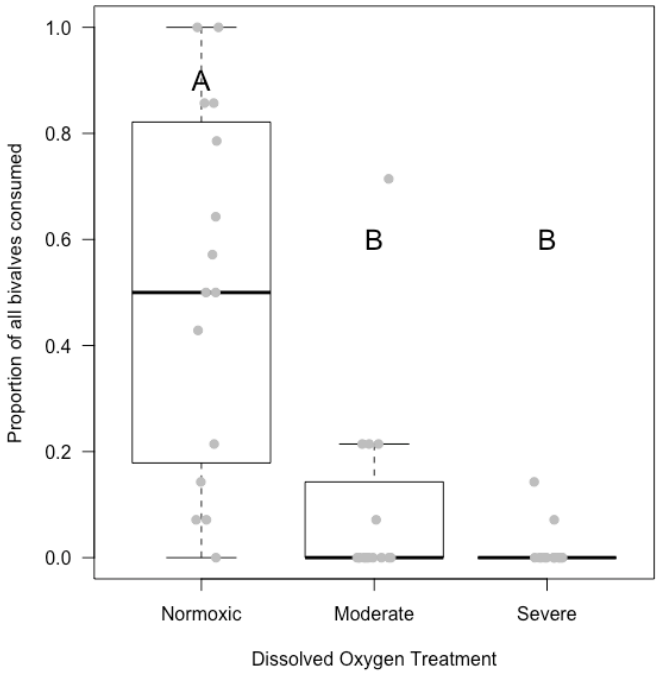
Figure 4. ( a ) Callinectes sapidus prey selection preference (Manly’s α ) for mussels ( Ischadium recurvum ) in laboratory experiments, grouped by dissolved oxygen regime; ( b ) Callinectes sapidus preference for oysters ( C. virginica ). In ( a ) and ( b ) preference values above 0.5, marked by a gray dotted line, indicate a preference for that prey species. There was a significant effect of dissolved oxygen regime in repeated measures ANOVA; letters indicate a significant difference in post-hoc Tukeys tests; ( c ) Proportion of mussels and oysters consumed in each dissolved oxygen regime. Ir: Ischadium recurvum, Cv: Crassostrea virginica. In box and whisker plots, black bars indicate the median value, box ends and whiskers indicate the interquartile and full ranges of the data, and gray points indicate data values.